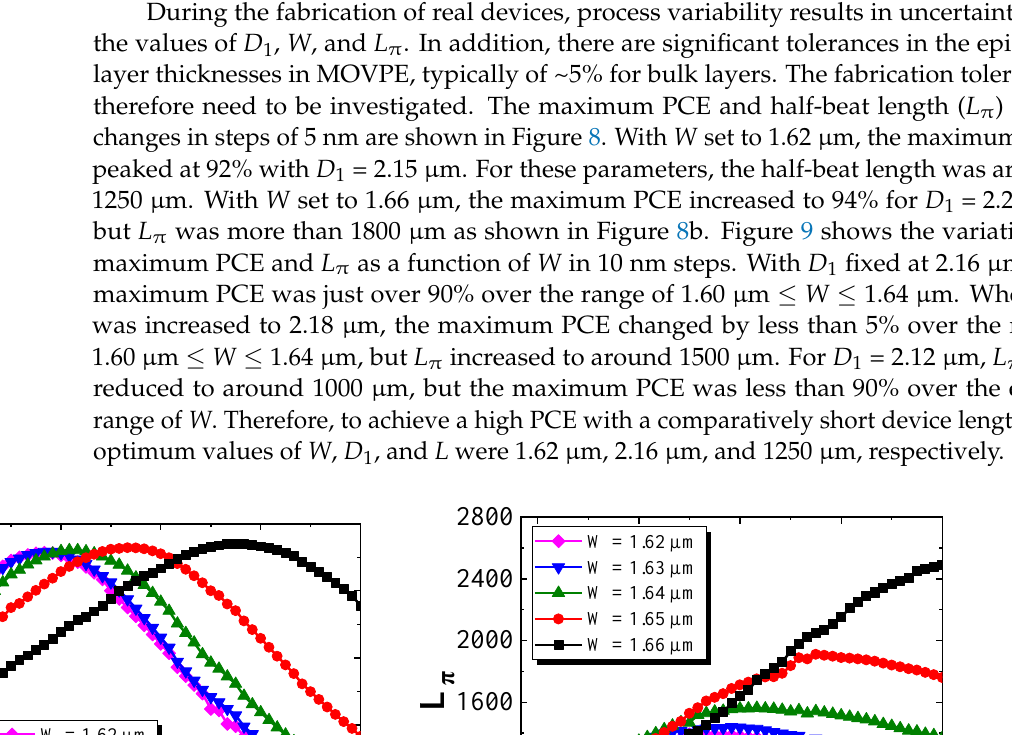
Figure 7. Electric field profiles of ( a ) TE 0 and ( b ) TM 0 eigenmodes for D 1 = 2.16 μ m, D 2 = 3.64 μ m, W = 1.62 μ m.